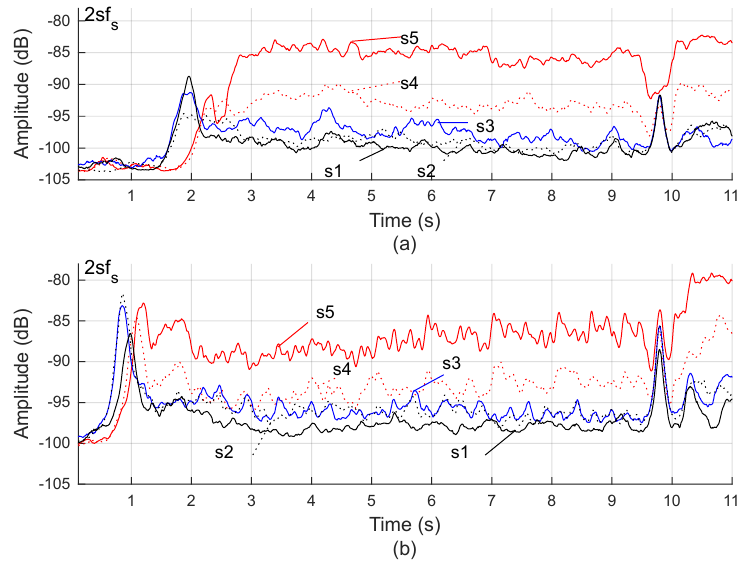
Figure 12. Time evolution of the 2 sf s amplitude during the startup transient for multiple severity cases under: ( a ) high load condition and ( b ) low load